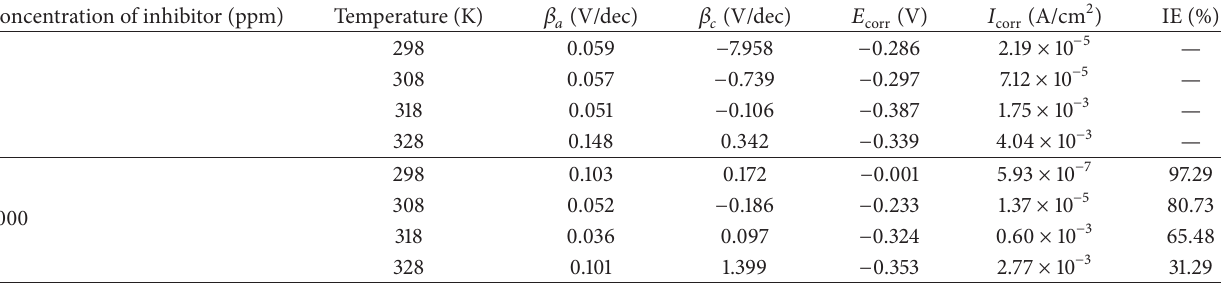
Table 2: The potentiodynamic polarization data of 304SS in the sulfuric acid 0.5 M without and with inhibitor at temperature variations. Concentration of inhibitor (ppm)